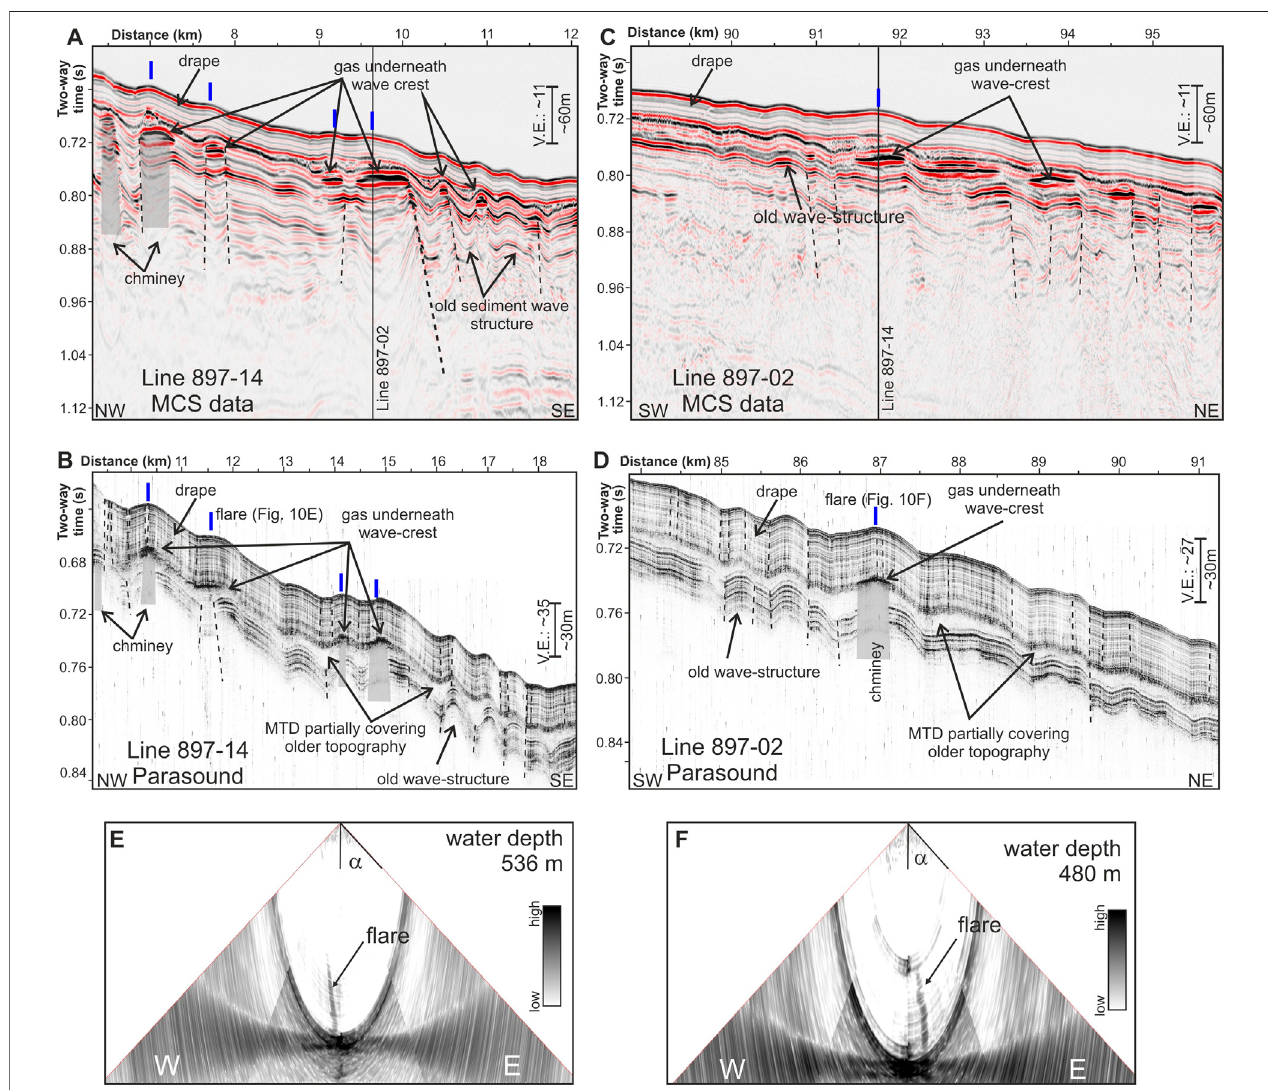
FIGURE10| Examplesofairgunmultichannelseismicdatashowingdeeper(older)sediment-wavesstructure,thataredrapedbytheveneerofsedimentimagedin sub-bottom pro fi ler data. (A,B) are coincident along line 897 – 14, (C,D) are coincident on line 897 – 02. Gas accumulates underneath the wave crests and in part penetrates the mass-transport deposit (MTD). Gas venting (vertical blue lines) occurs at the sea fl oor where upward gas migration from the lower accumulation is facilitated by small-offset discontinuities (faults) in the overlying veneer (drape) of layered sediments. These faults (black dashed lines) are created from the rough topography of the MTD. (E,F) Examples of gas fl ares from the EM122 water column data (expedition MSM34). Beam-opening angle α is 60 ° .